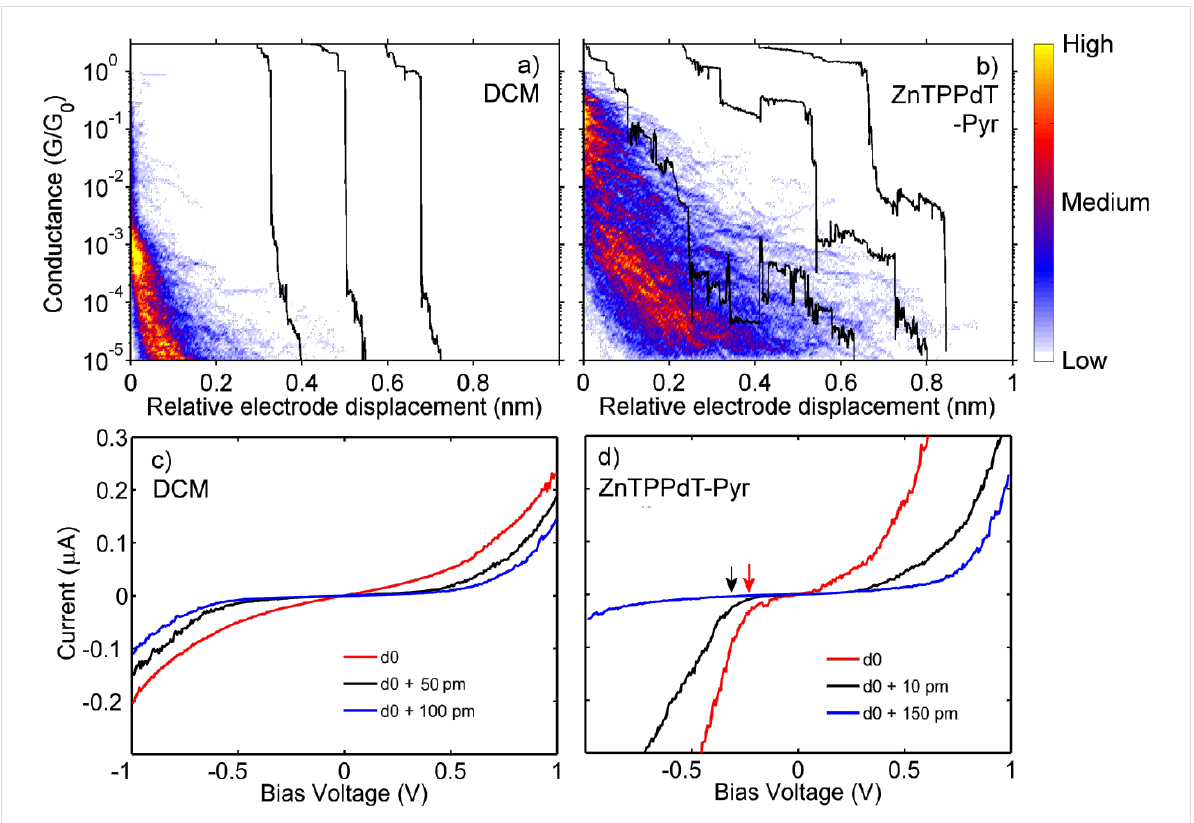
Figure 2: Trace histograms constructed from 500 consecutive breaking traces taken at room temperature and 100 mV bias for junctions exposed to (a) the solvent DCM only, and (b) to ZnTPPdT–Pyr. Regions of high counts represent the most probable breaking behavior of the contact. The black curves are examples of individual breaking traces (offset along the horizontal axis, d , for clarity). For the construction of the trace histograms, the zero of the relative electrode displacement for each curve was set to the point where the conductance drops sharply below 1 G 0 . (c) Current–voltage char- acteristics taken at various electrode spacings starting from the initial value d 0 of junctions exposed to the solvent DCM, and (d) to